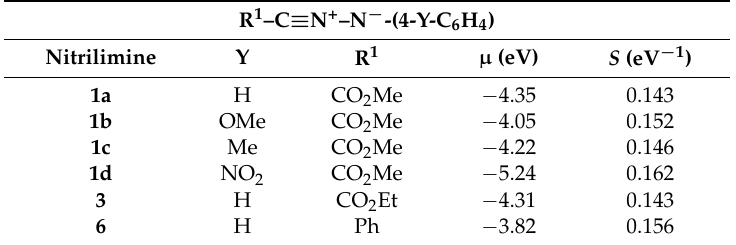
Table 6. Calculated chemical potential µ and global softness S of the investigated nitrilimines.